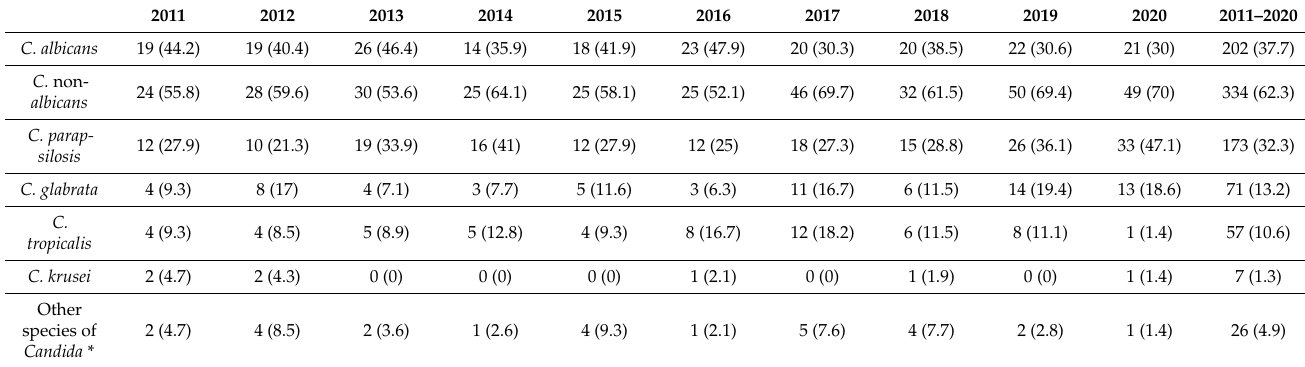
Table 1. Distribution of Candida species in regards to the year.